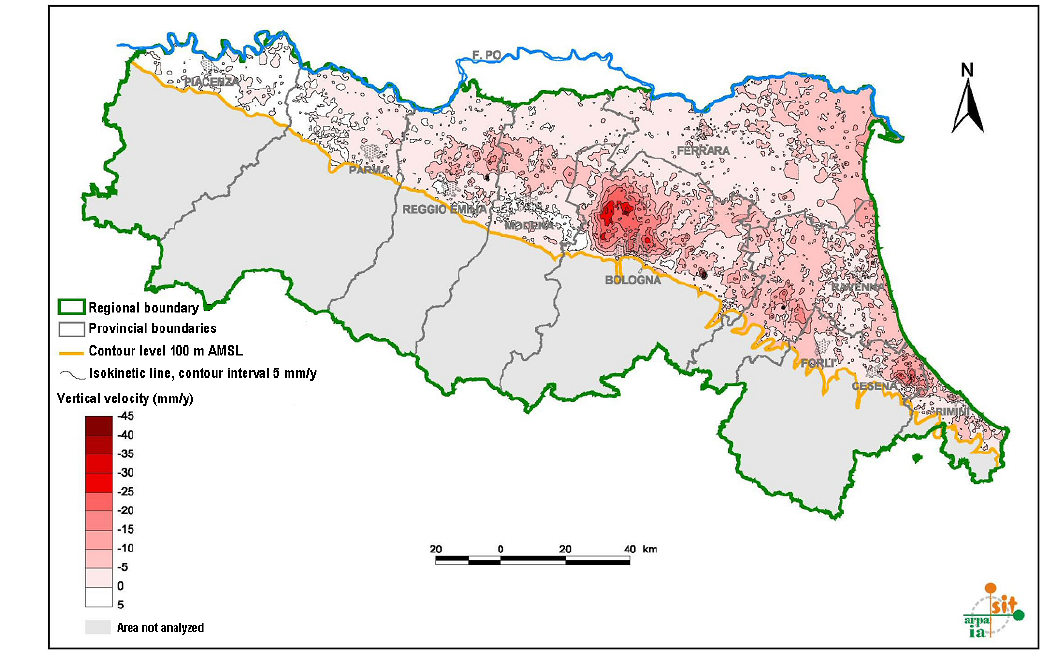
Figure 3. Subsidence map (mmyear − 1 ) for the period 2002–2006.